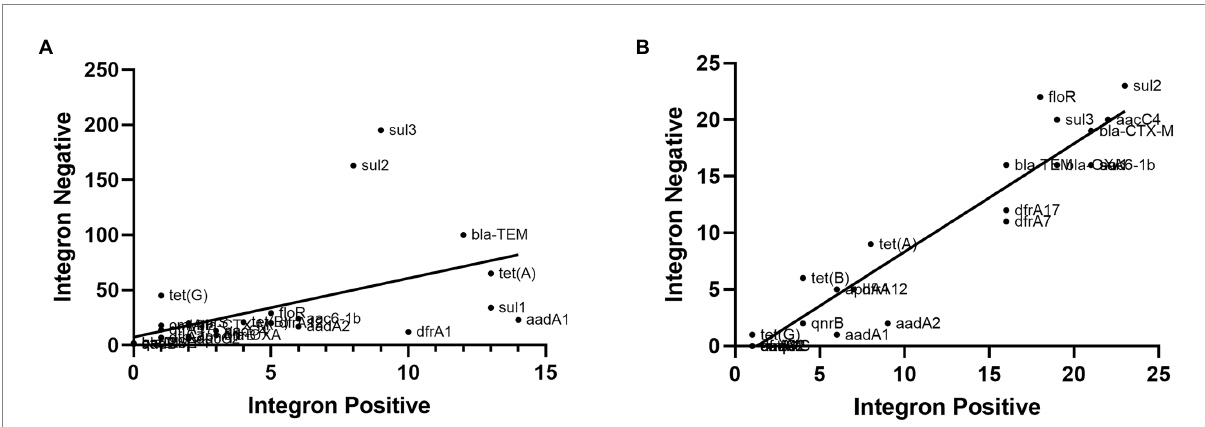
FIGURE 6 The correlations between class 1 integrons and antibiotic resistance genes of all 200 non- Salmonella Indiana isolates and S . Indiana isolates. (A) The correlations between class 1 integrons and antibiotic resistance genes of all 200 non- Salmonella Indiana isolates. (B) The correlations between class 1 integrons and antibiotic resistance genes of S . Indiana